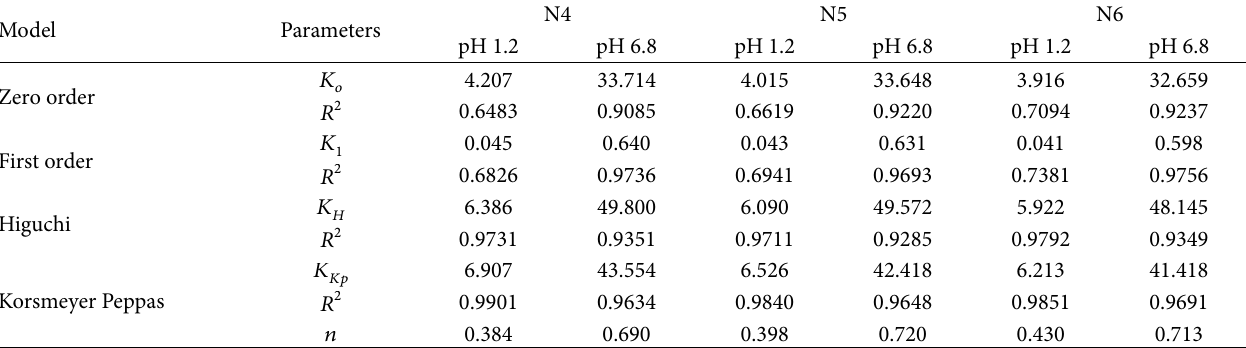
Table 5: Models of in-vitro drug release kinetics of PEG-g-poly (MAA) nanogels formulations with varying concentration of MAA. Model